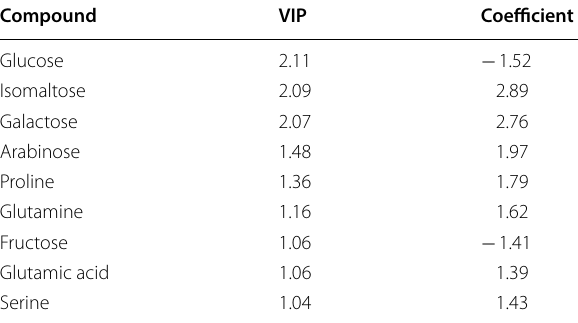
Table 2 Compound selected by variables in the